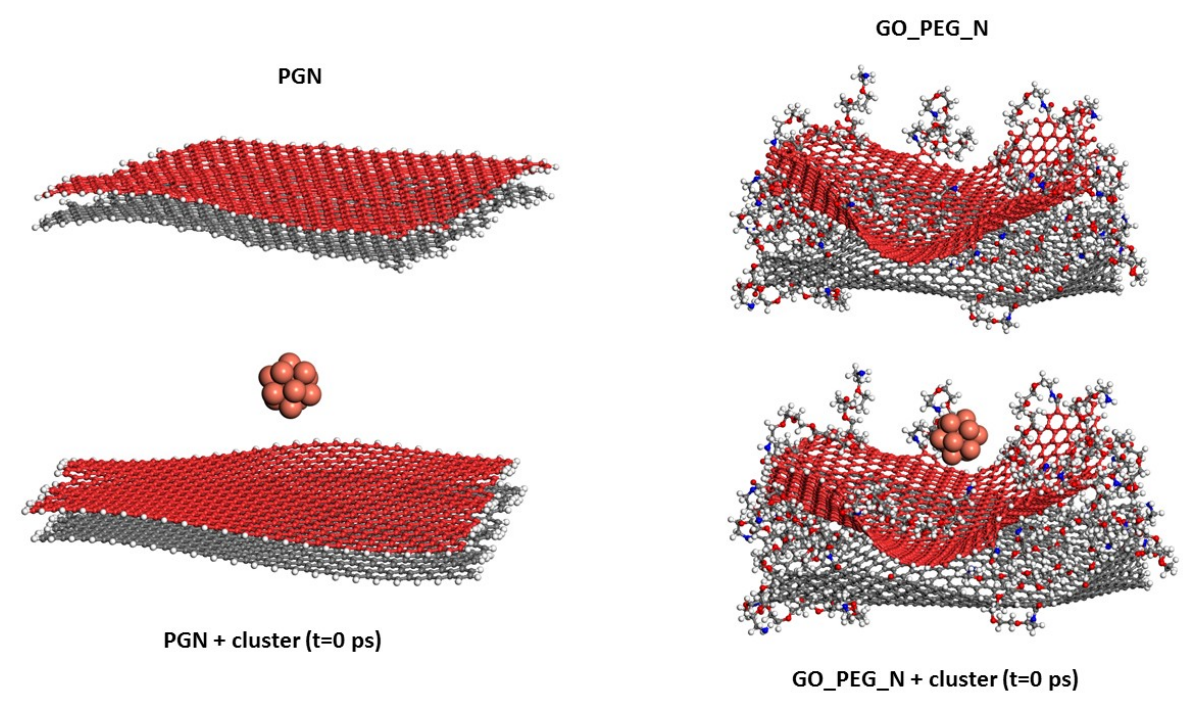
Figure 1. Models of PG, GO_PEG, and clusters. The starting structures used in the simulations before cluster adsorption on both surfaces are shown in the lower part of the figure.